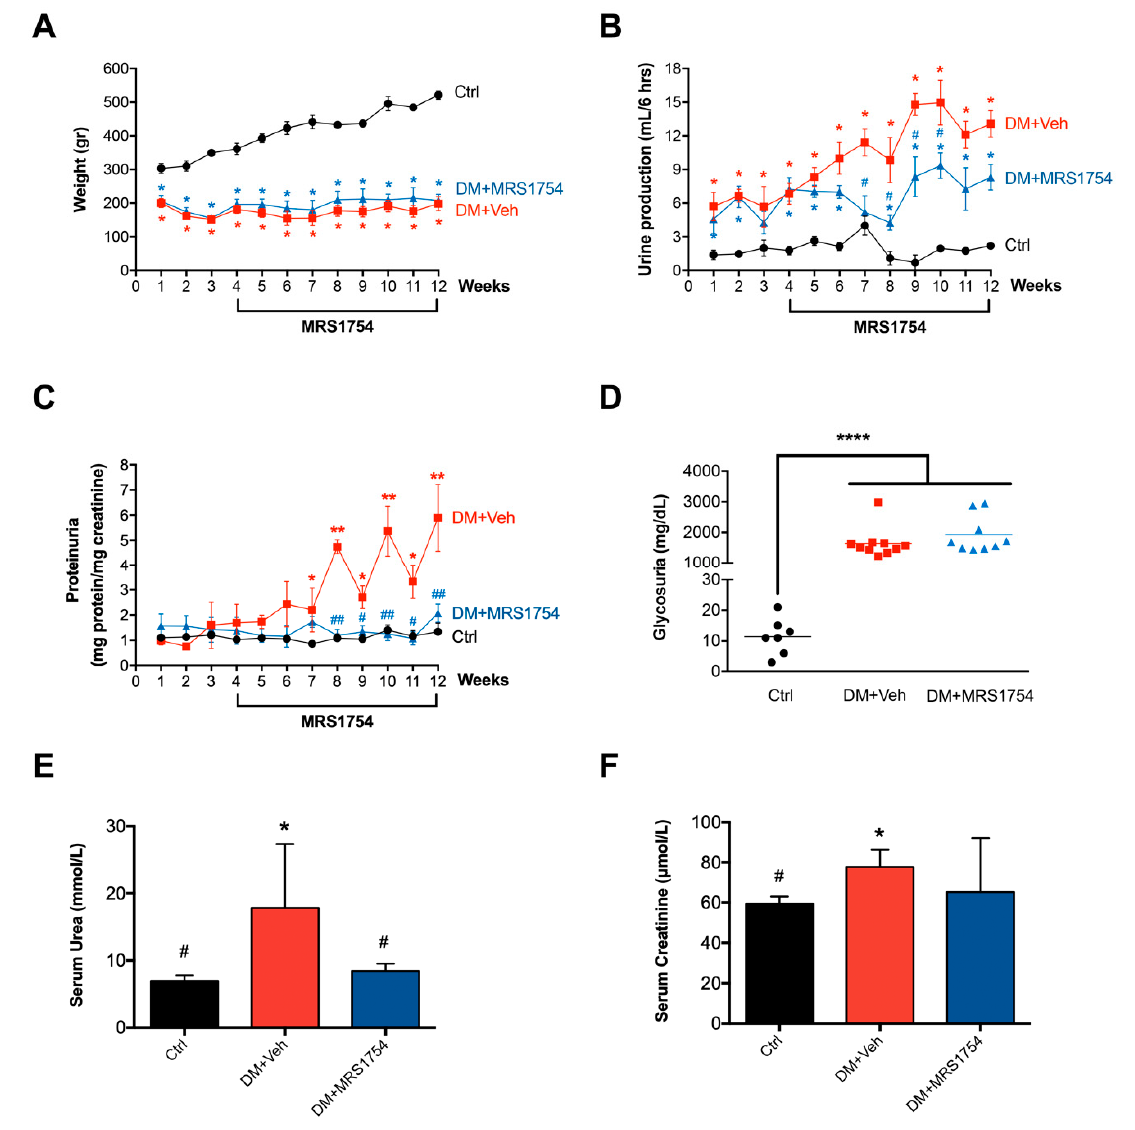
Figure 1. In vivo pharmacological blockade of A 2B AR attenuates the clinical signs of glomerular injuries in diabetic nephropathy rats. Pathophysiological parameters of renal function were evaluated in non-diabetic (black; control (Ctrl)), diabetic vehicle-treated (red; DM+Veh) and diabetic MRS1754-treated (blue; DM+MRS1754) rats for twelve weeks post-streptozotocin (STZ) inoculation. Diabetic rats were treated with MRS1754 (0.5 mg/kg/48 h) for eight weeks, four weeks after STZ inoculation. ( A ) Weight (grams) was determined each week and urine was collected in a metabolic cage for 6 h to measure its ( B ) production (mL), ( C ) protein (mg protein/mg creatinine) and ( D ) glucose (mg/dL) content. Proteinuria was normalized to creatinine (mg protein/mg creatinine). ( E ) Urea (mmol/L), and ( F ) creatinine ( μ mol/L) were quantified in the serum at twelve weeks post-STZ inoculation. Glycosuria, serum concentration of urea, and creatinine were measured at twelve weeks after STZ inoculation. Graphs represent the mean ± S.D. * p < 0.05, ** p < 0.01, **** p < 0.001 versus Ctrl rats. # p < 0.05, ## p < 0.01 DM+MRS1754 versus DM+Veh rats. n = 6.